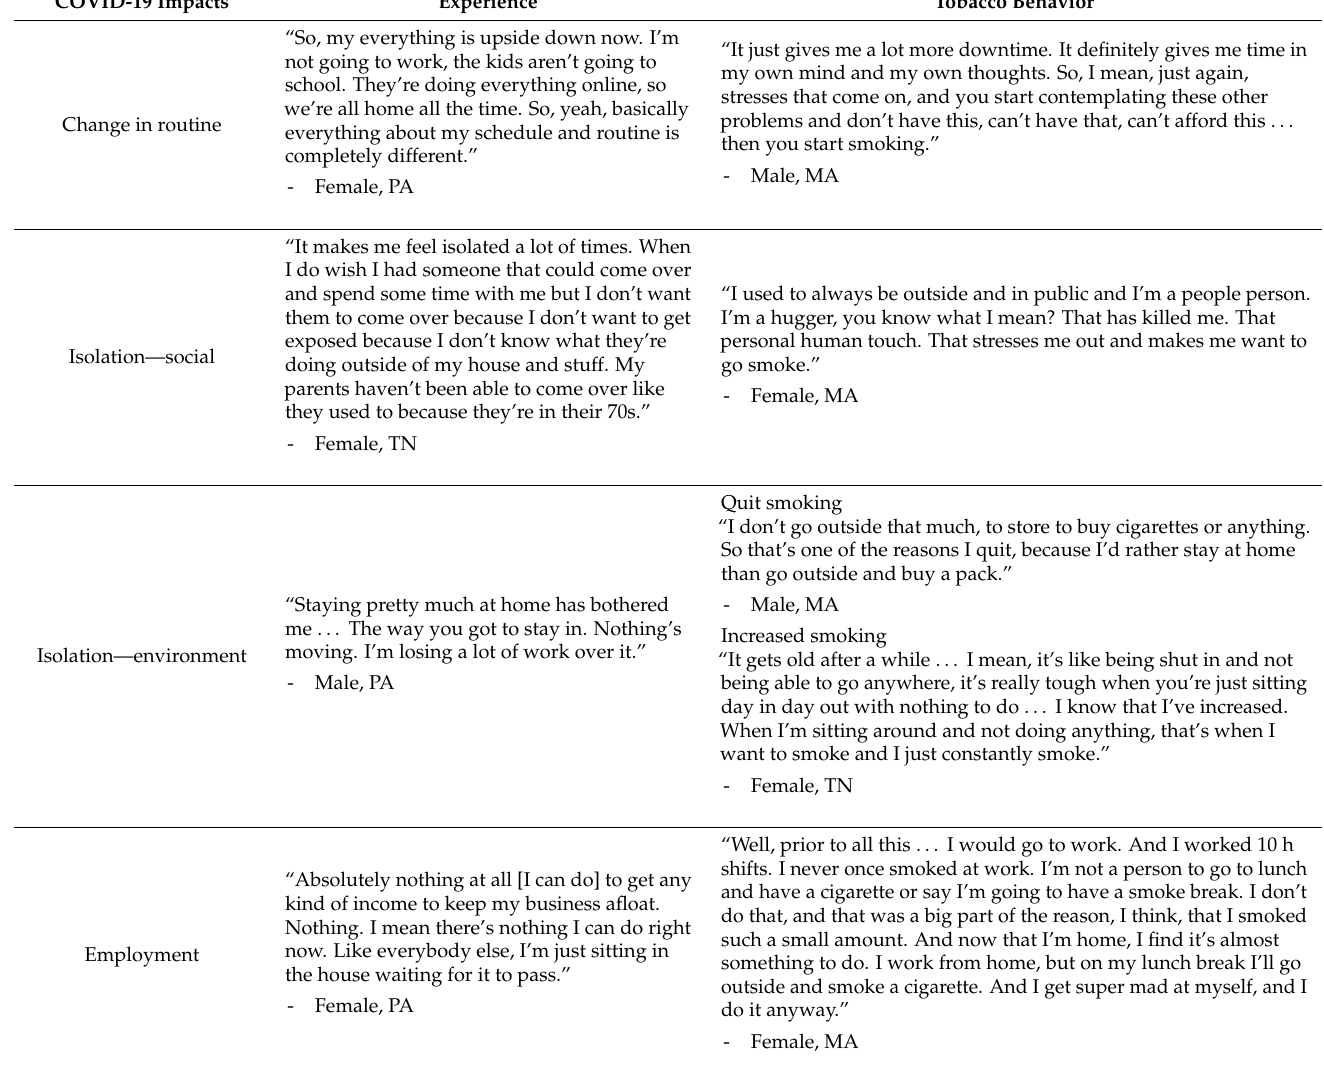
Table 1 highlights identified COVID-19 impacts and reactions, with example quotes